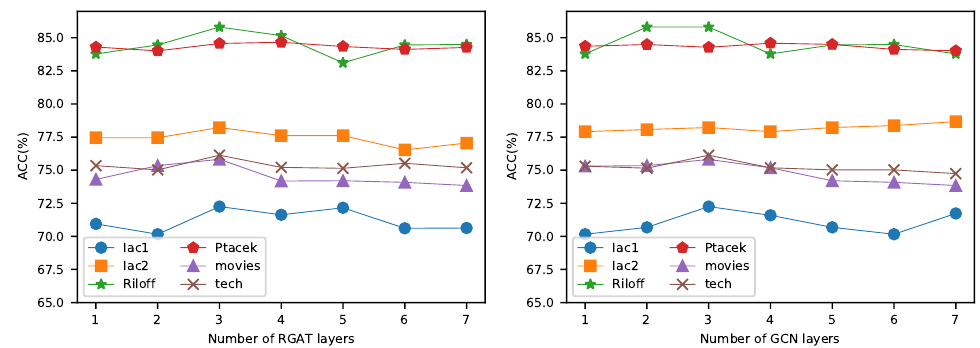
Figure 4. Impact of the number of stacked layers. The left figure fixes the GCN layers to 3 and records the model’s performance with a different number of RGAT layers. The right figure fixes the RGAT layers to 3 and records the results of the model with a different number of GCN